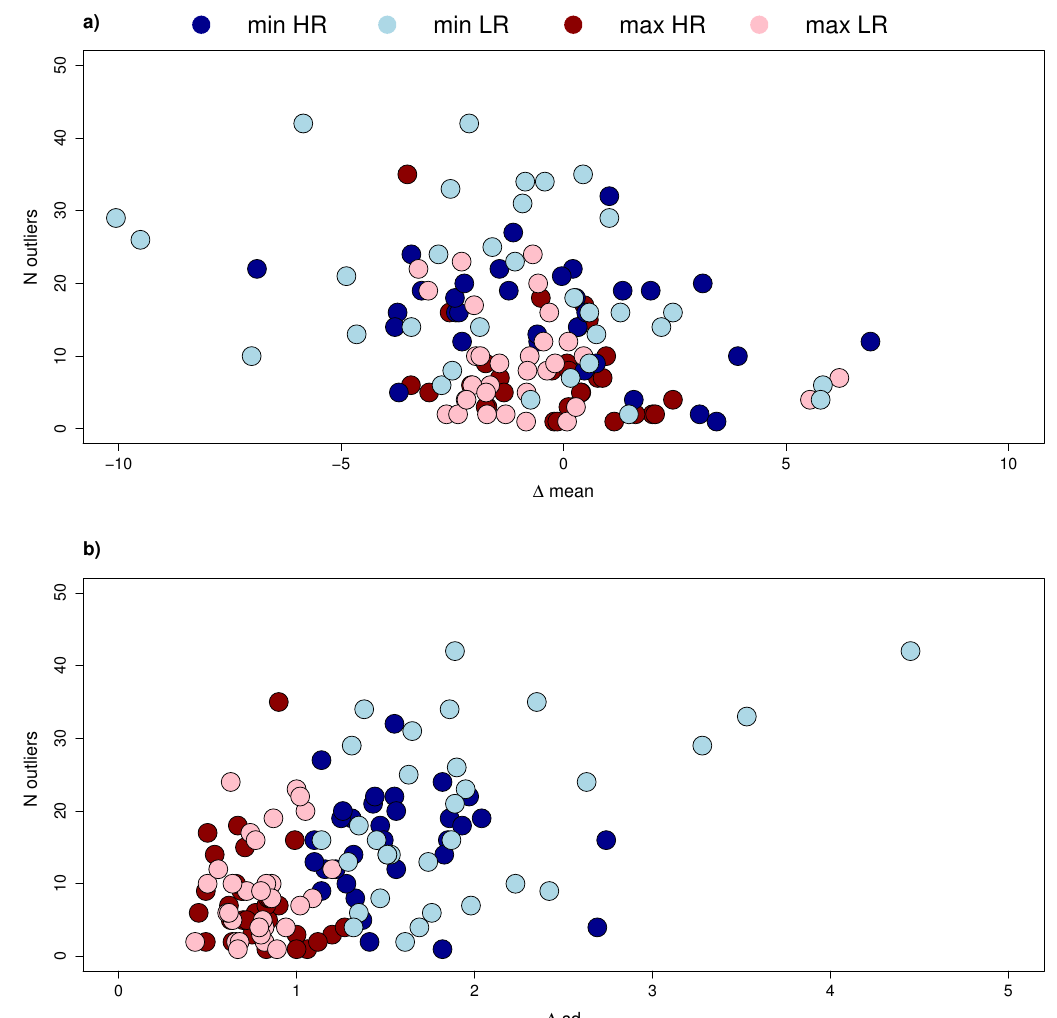
Figure 5. Number of outliers vs. ( a ) Mean of the biases (EMM) and ( b ) standard deviation (SDM) for each model and two bin lengths ( m = 1, m = 4). Dark blue represents cold temperature extremes for the 16 models having higher resolution while light blue represents cold temperature extremes for the 16 models at lower resolution. For hot temperature extremes, dark red represents higher resolution and pink lower resolution. Detailed statistical information in Table